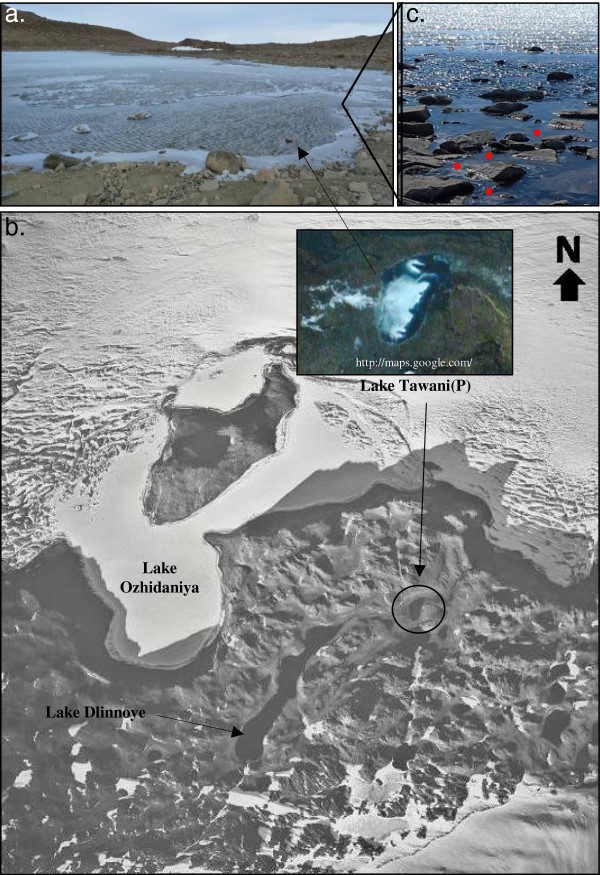
a: Partial picture of Lake Tawani(P) in Schirmacher Oasis, Antarctica.b: The satellite picture of Lake Tawani(P) and its vicinity. Note the continuation of the channel from the Lake Tawani(P) to the ice-shelf along a lineament marking the presence of a fossil valley and beyond connecting landlocked and proglacial lakes. Lake Tawani(P) is situated in this fossil valley and acts as a catchment for the overflow of snow and glacial melt feeding the lake. The inset is the Google Earth (
http://maps.google.com) satellite picture showing Lake Tawani(P). c: Actual location where samples were collected in Lake Tawani(P). The red dots indicate the rock-water interface in which sample collection occurred.